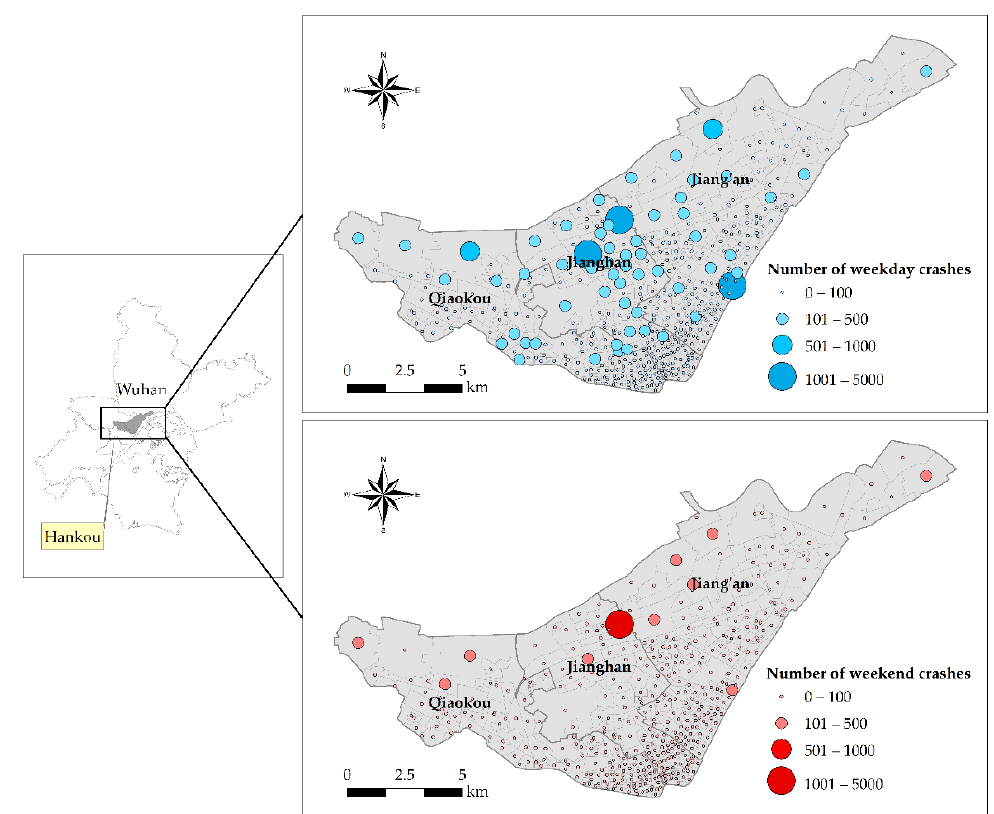
Figure 1. Location of the study area and spatial distribution of the number of traffic crashes per community.